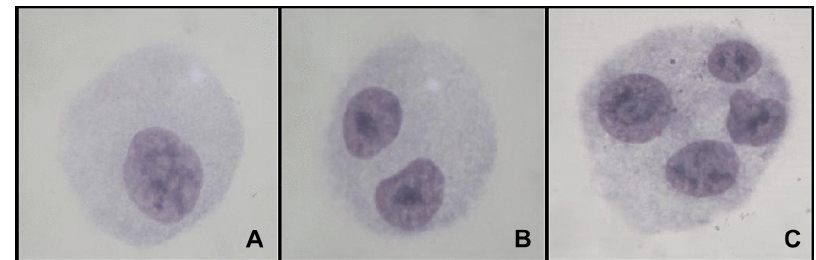
Figure 2. Mononucleated (A), binucleate (B) and multinucleate HTC cells (C).